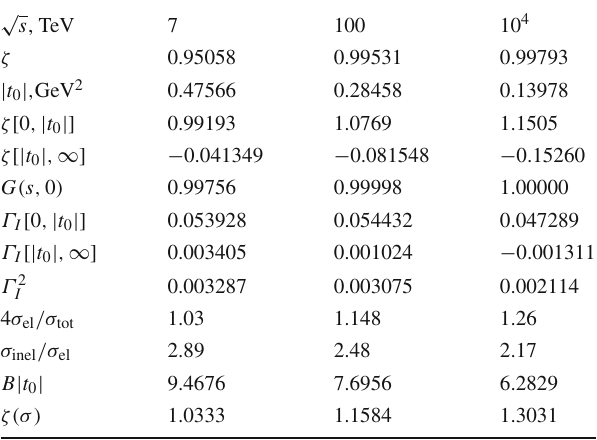
Fig. 2 The fit of the B -data (Fig. 1) by the kfk-model (the dotted line). The dashed line B I indicates that the slope is well accounted by the imaginary part of the amplitude alone Table 1 The energy behavior of main pp -characteristics of the kfk- model (their detailed explanation is given in the text)